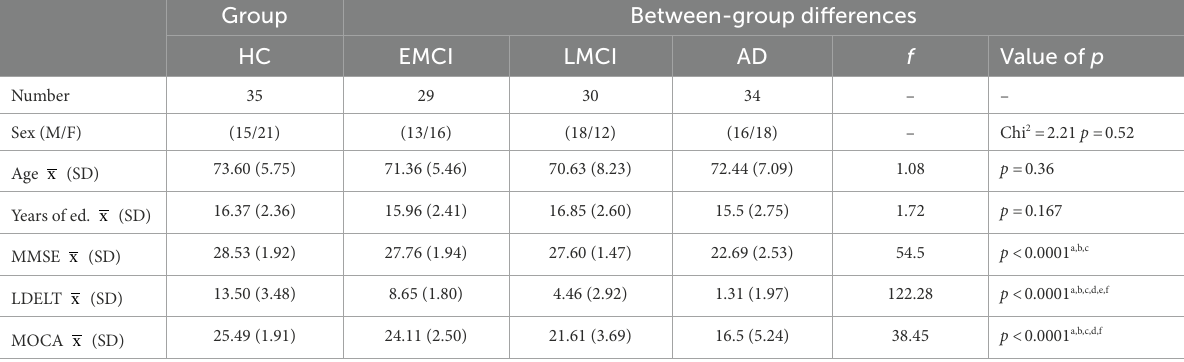
TABLE 1 Information of the participants included in this study.